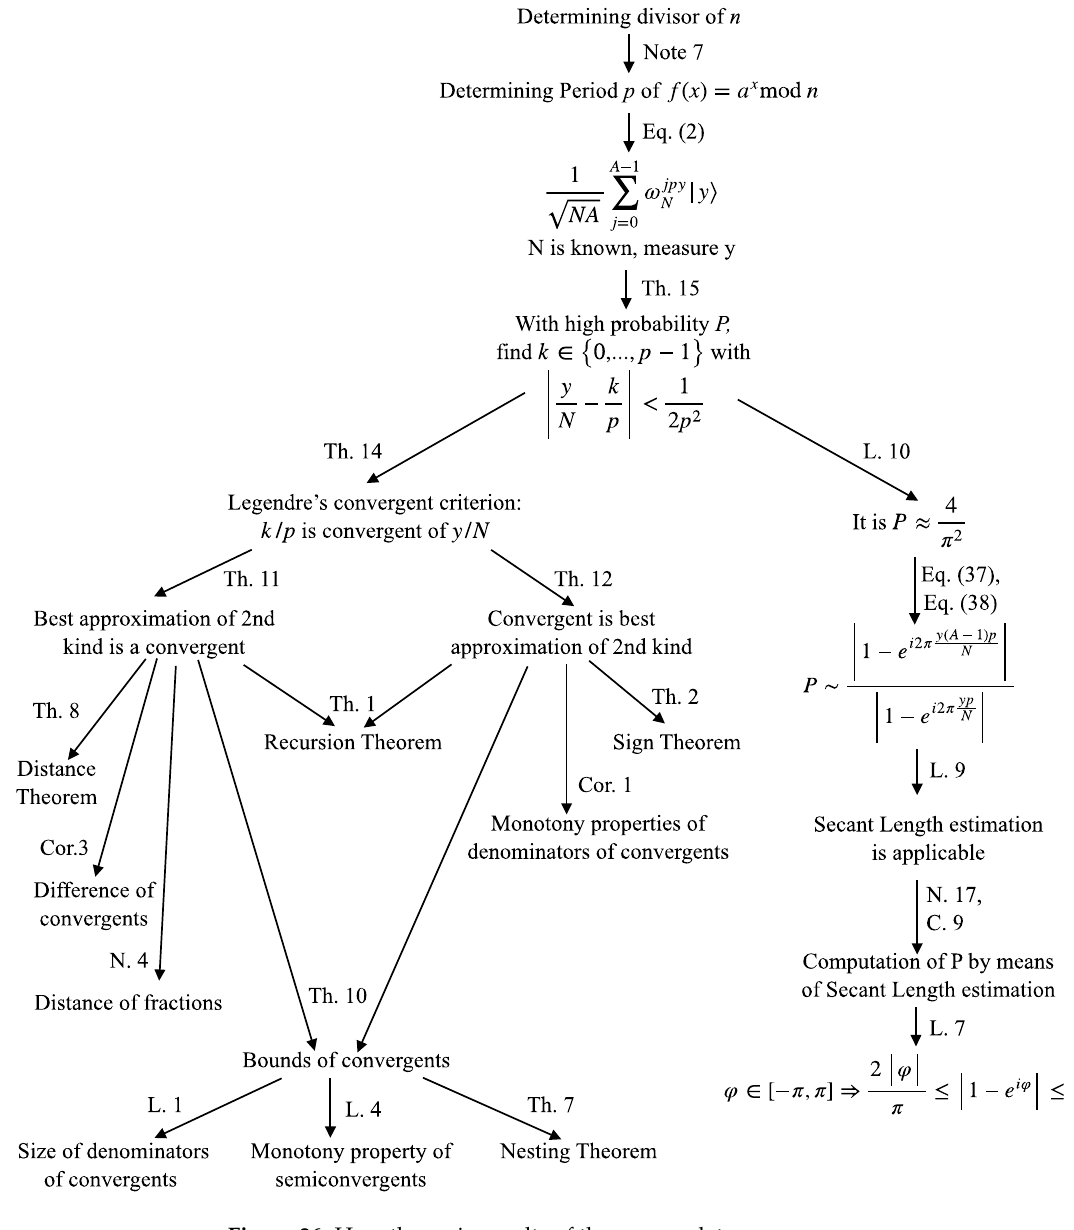
Figure 26. How the main results of the paper relate.